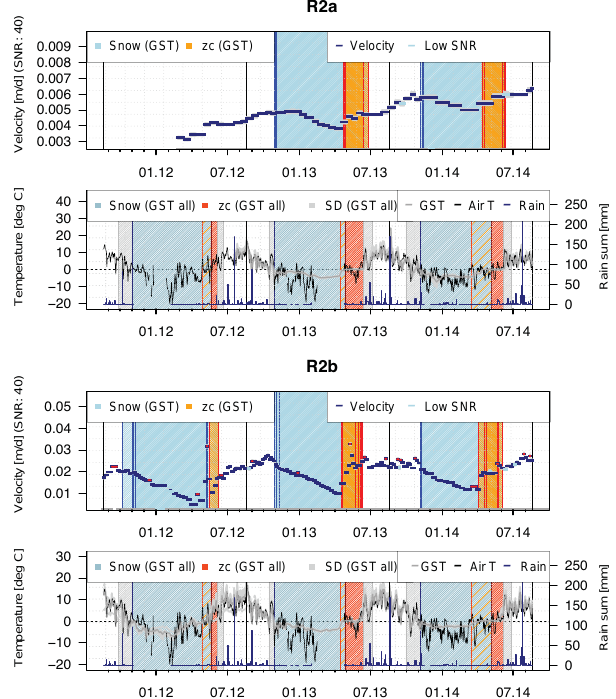
Figure 4. Comparison of the horizontal velocities to meteorological factors for Breithorn rock glacier (R2a and b). Vertical black lines separate the 3 different years of observation (2011/12, 2012/13, 2013/14). Top: horizontal velocity (dark blue), its standard devia- tion (grey), and velocity periods detected as peaks (red dots), pe- riods with an SNR below SNR-t are indicated in light blue. Grey dots at the bottom indicate days with available GPS positions. Zero curtain period (orange) and insulating snow cover (light blue) are both estimated from individual iButtons next to the GPS station (the vertical blue lines indicate the start of insulating snow cover at the individual iButtons and the vertical orange line represents the end of the zero curtain period). Bottom: daily amount of liquid precipi- tation (dark blue bars), air temperature (black line), and GST (grey line, iButtons next to GPS station; bold line refers to the median over all iButtons). Insulating snow cover (blue, earliest in grey) and zero curtain periods (dark orange, earliest shaded in orange, latest in grey) as derived from all iButtons in the study